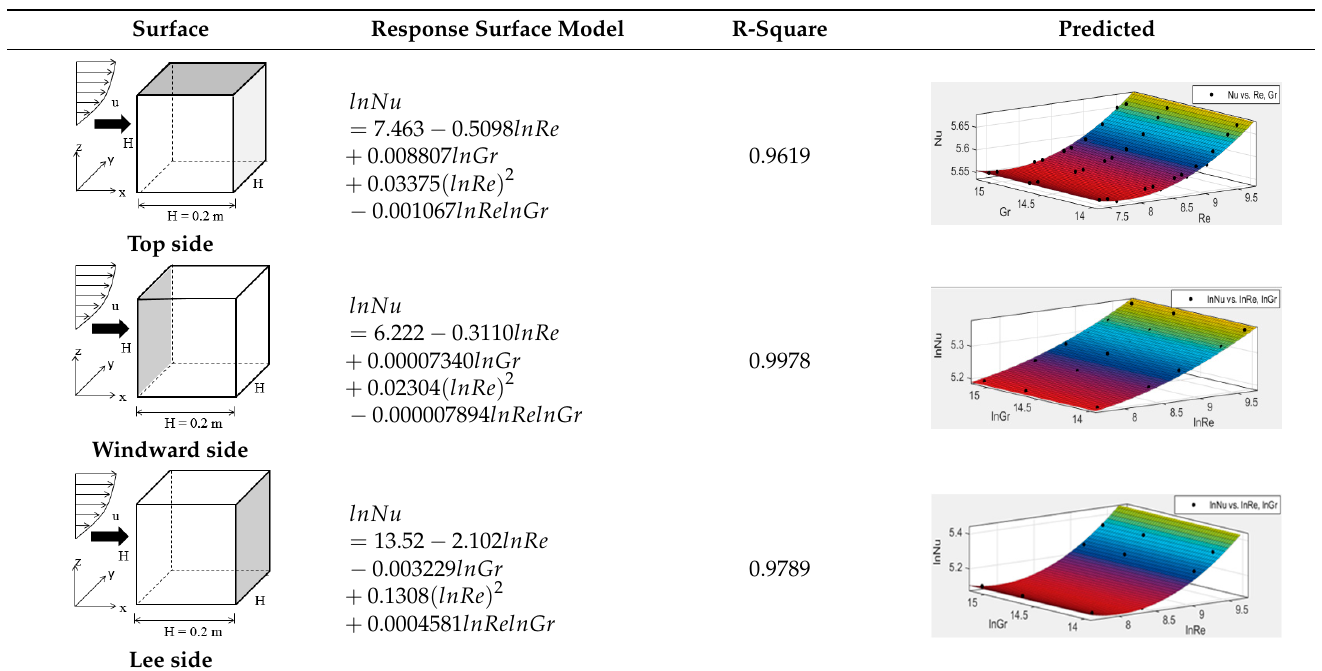
Table 4. RSM fitting formulas under the 0° wind direction condition.